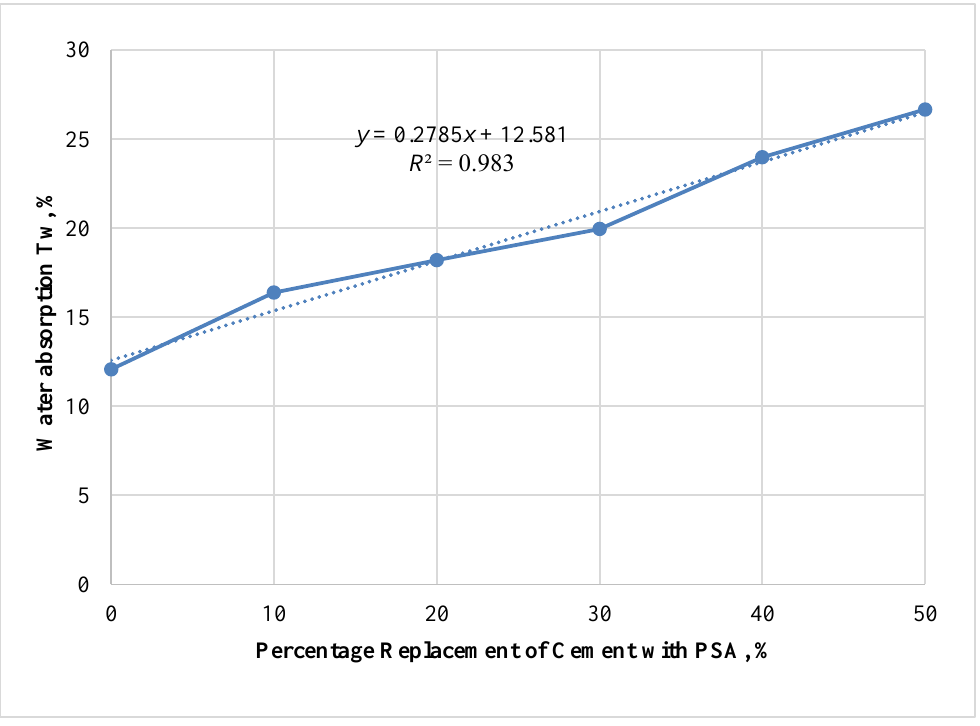
Fig. 2. Regression plot of water absorption on the 28 th day.